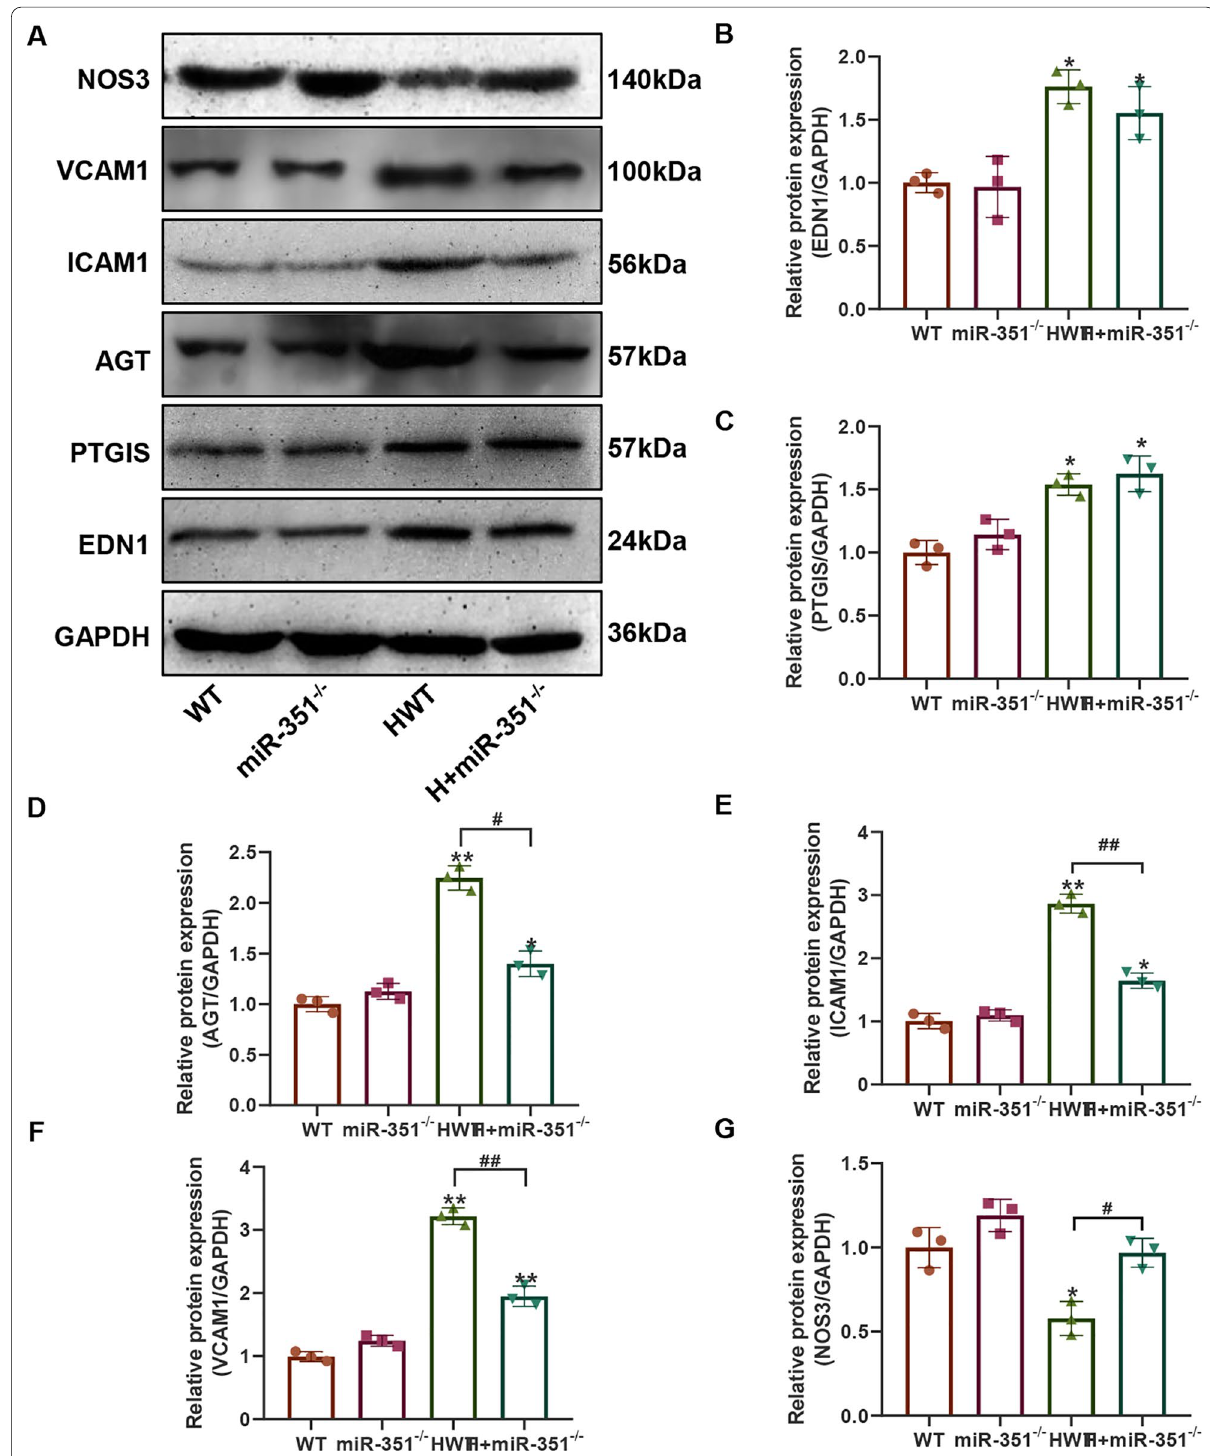
Fig. 4 Western blot results of atherosclerotic-related proteins in miR-351 KO mice . A Western blot detection results. B ImageJ quantified statistical results of the NOS3 band gray values. C ImageJ quantitative statistical results of the VCAM1 densitometry values. D ImageJ quantitative statistical results of the ICAM1 band gray values. E ImageJ quantitative statistical results of the AGT band gray values. F ImageJ quantitative statistical results of the PTGIS band gray values. G ImageJ quantitative statistical results of the EDN1 strip gray values. **P < 0.01, *P < 0.05, vs. the WT group. # P < 0.05 represents the comparison between the two groups of connections. N 3 mice per =